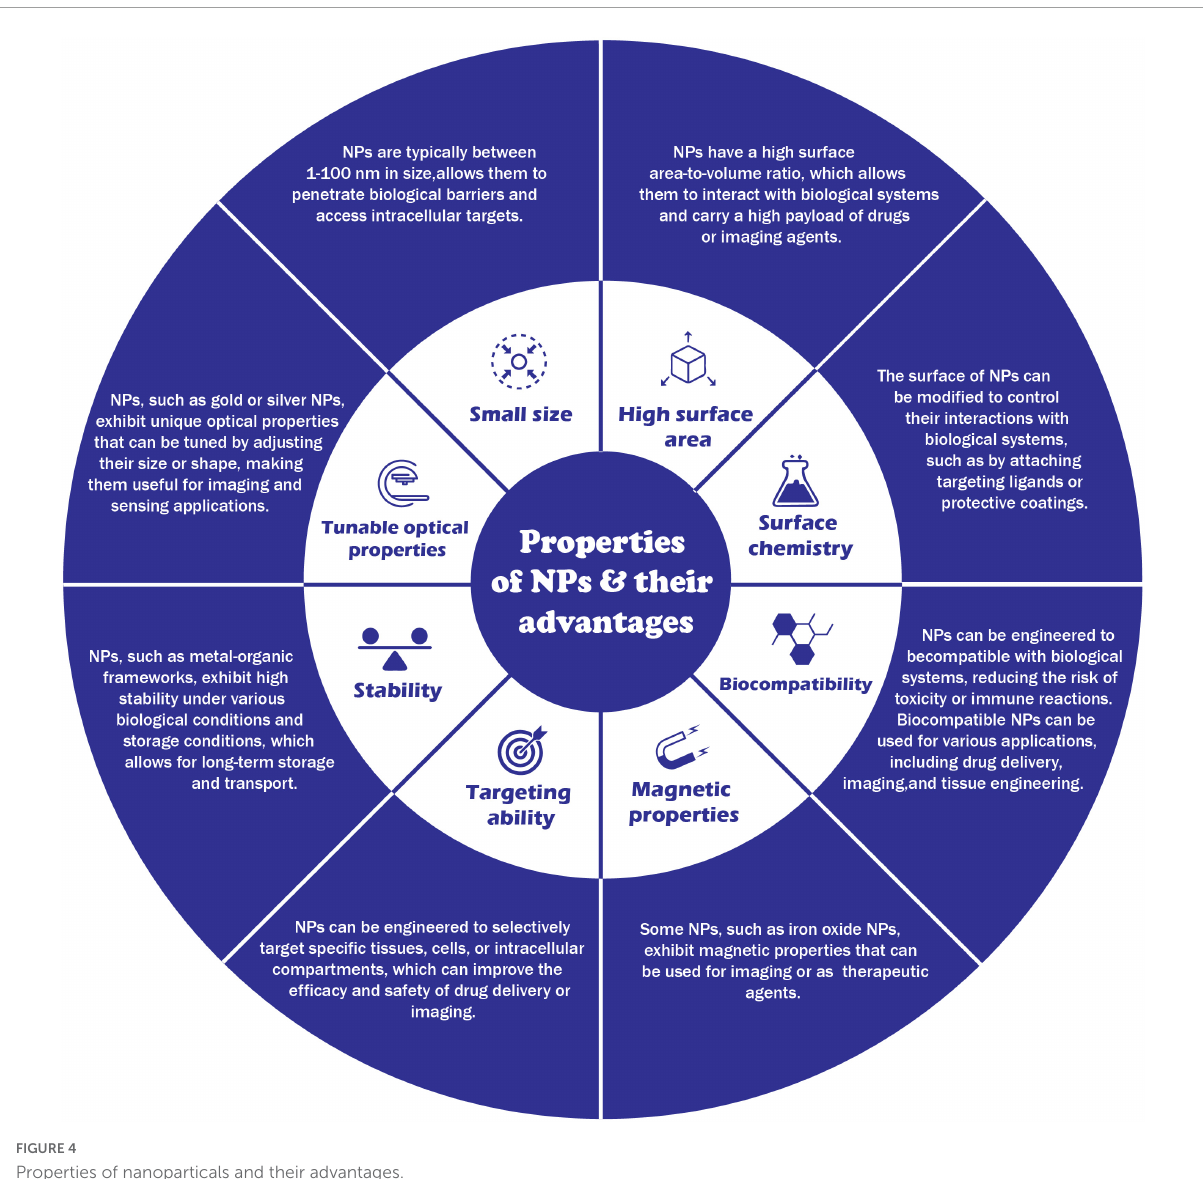
and NADH-dependent enzymes may cause the bioreduction of Au (3+) to Au (0) and the generation of gold nanoparticles. By using NADH-dependent reductase as an electron carrier, it is possible to start the reduction of gold ions (Sriram et al.,